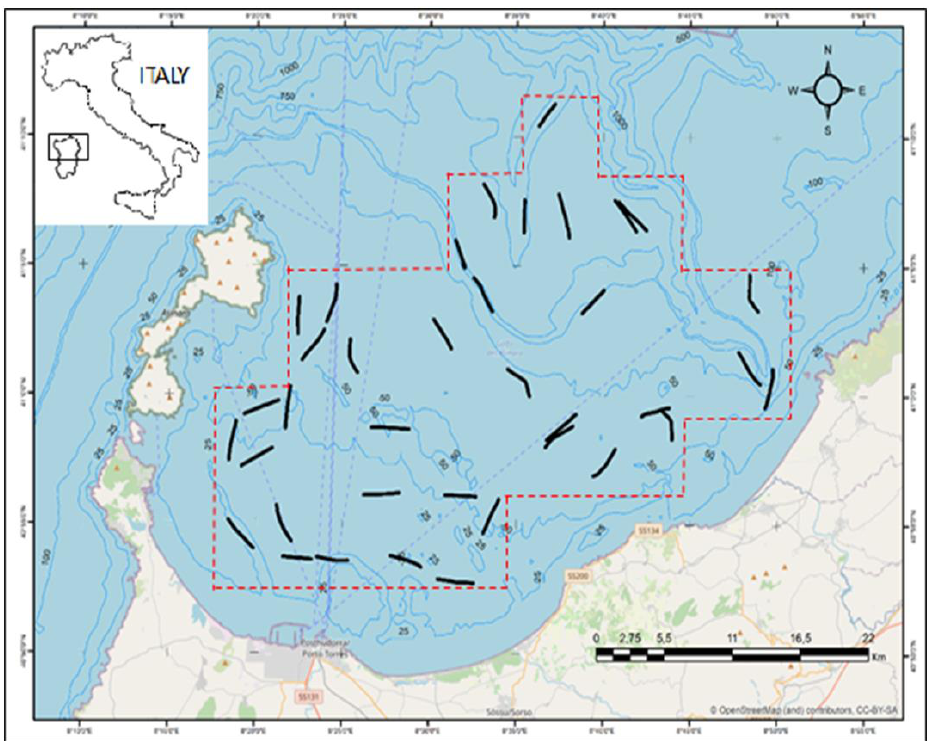
Figure 1. The sampling area (Asinara Gulf, NW Sardinia, Italy) was explored during a fishery-independent trawl survey during June – October 2022. Dark lines represent the 35 hauls, plus 2 repeated (due to technical problems: overlapping dark lines) hauls, performed and distributed within the grid of 5 km × 5 km squares (red dotted lines) selected for fishing operations.